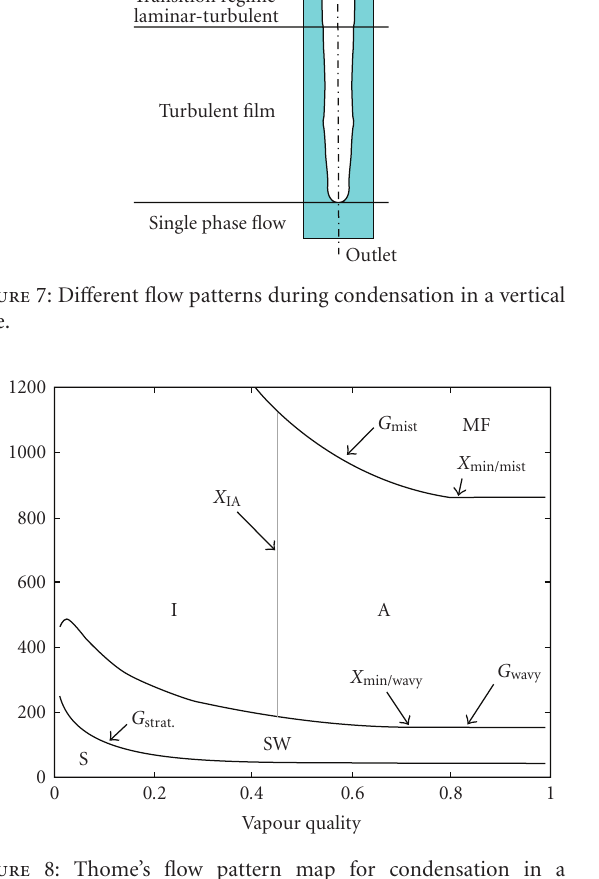
Figure 10: Heat transfer model showing convective and falling